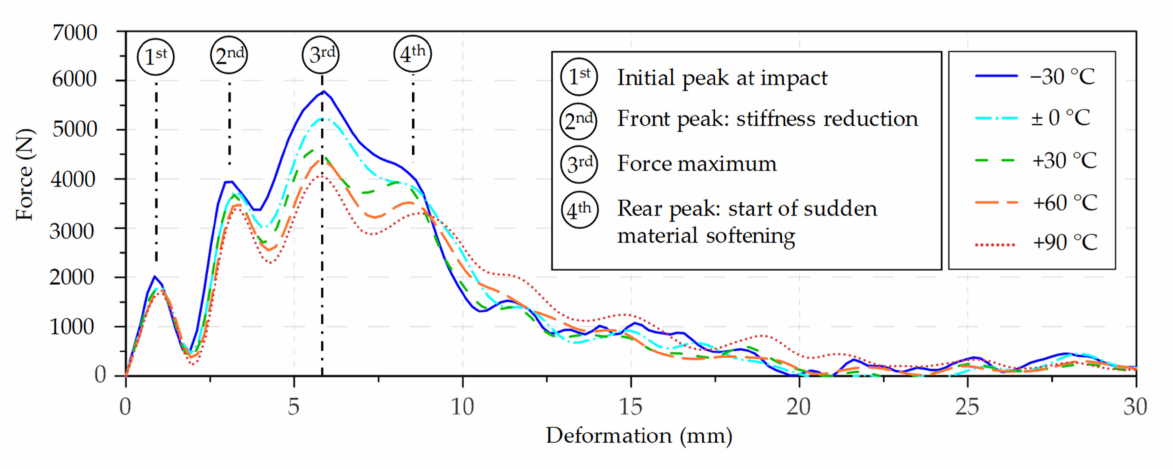
Figure 6. Force–deformation diagram of the mean value curves of birch wood by temperature